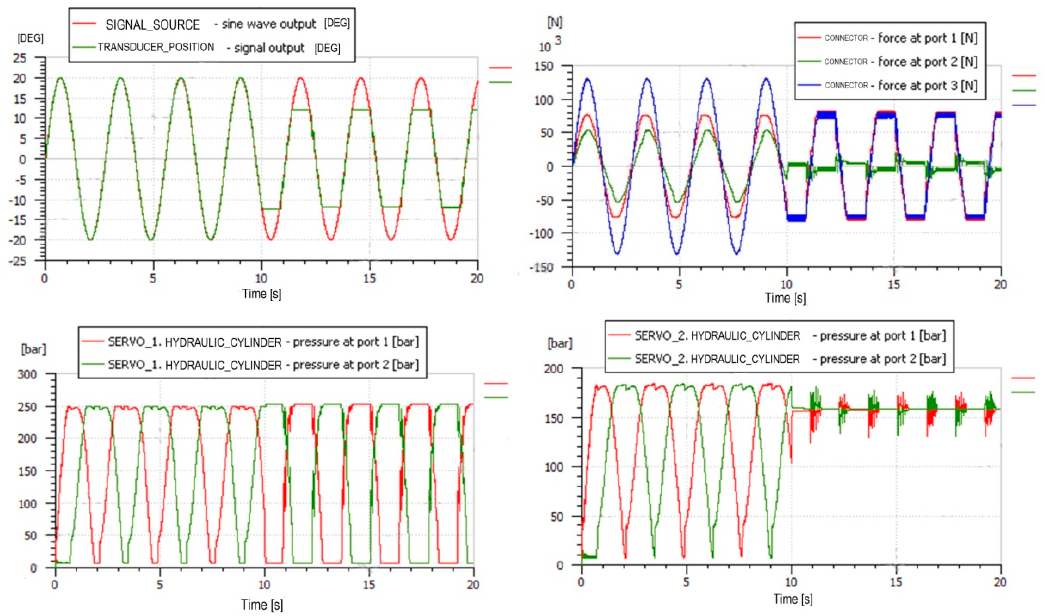
Figure 6. System behavior with failure of one servo.